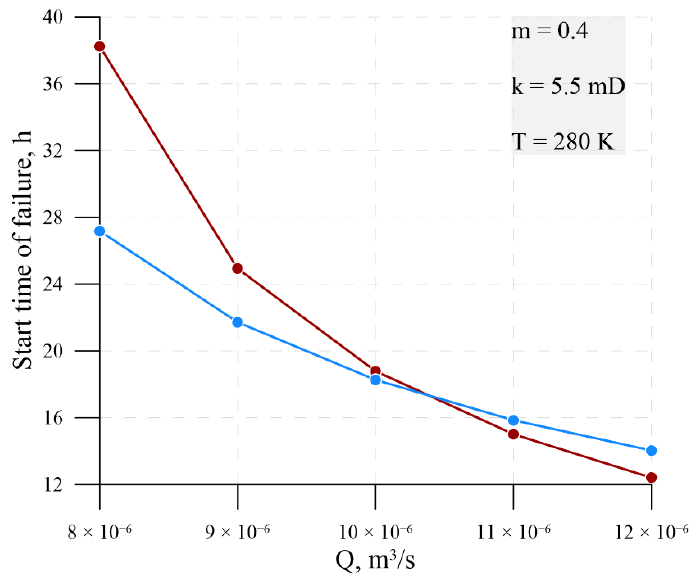
Figure 5. Flow rate dependence of the failure onset.